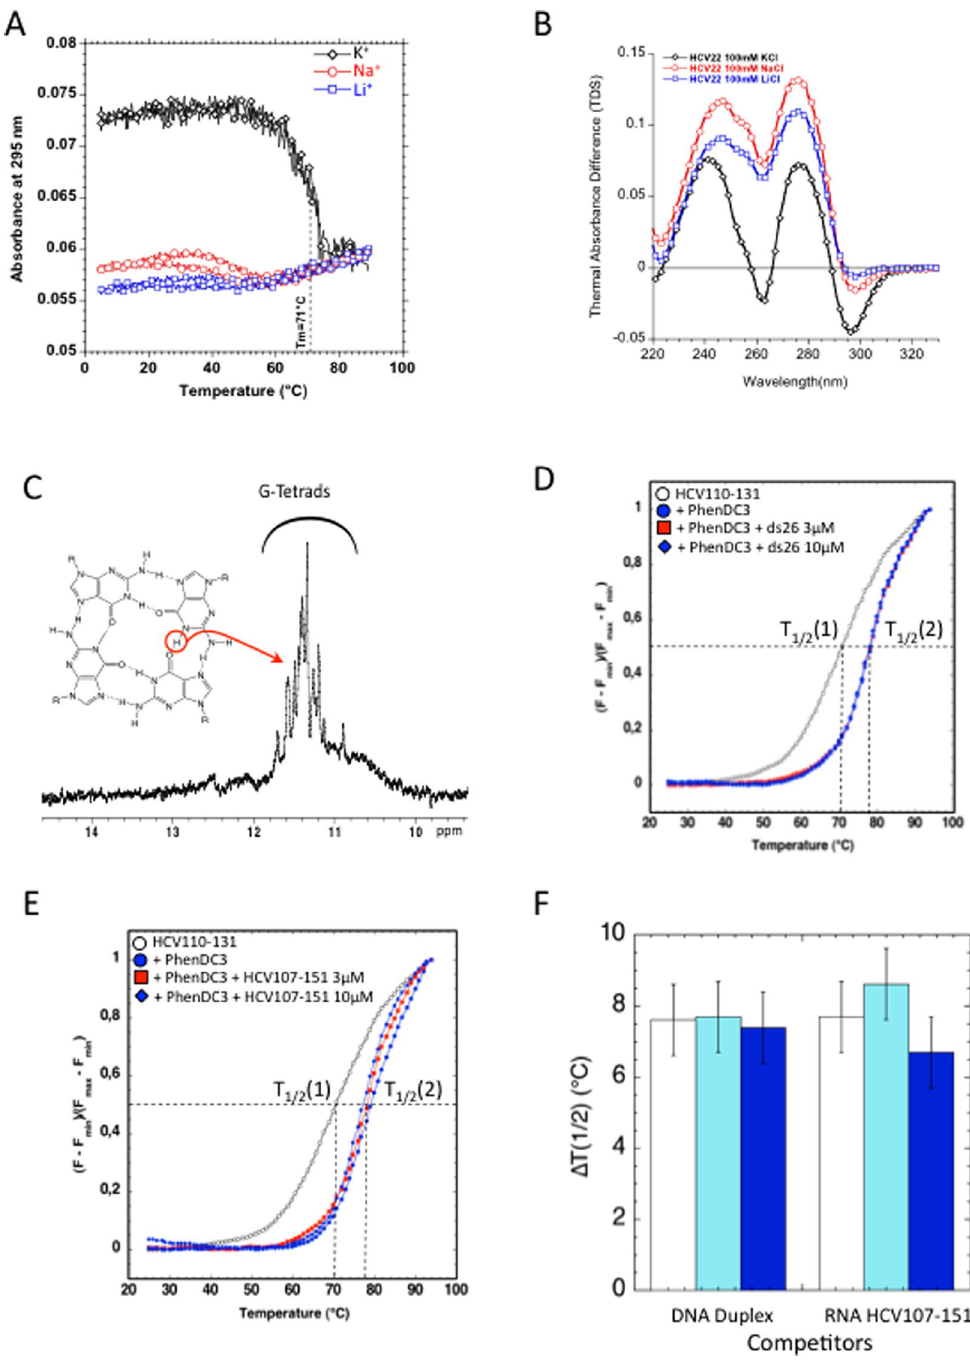
Figure 2. Biophysical evidence of RNA G4 formation at the 3 ′ end of HCV negative strand. ( A ) Melting profiles from HCV110-131 5 ′ CGGGAGGGGGGGUCCUGGAGGC3 ′ recorded at 295 nm in the presence of 10 mM lithium cacodylate buffer, pH 7.0 at 22 °C, containing either 100 mM of KCl, NaCl or LiCl. The HCV110- 131 oligonucleotide concentration was 2.5 µ M. ( B ) Thermal differential spectra recorded in the presence of 10 mM lithium cacodylate buffer, pH 7.0, containing either 100 mM of KCl, NaCl or LiCl. The HCV110-131 oligonucleotide concentration was 2.5 µ M. ( C ) 1 H, 1D NMR spectrum recorded in 20 mM potassium phosphate buffer, pH 7, containing 70 mM KCl. The oligonucleotide concentration was 100 µ M. D , E , F . FRET-melting assay recorded for f-HCV110-131-t RNA at 0.2 µ M in 10 mM lithium cacodylate pH 7.2 containing 10 mM KCl and 10 mM LiCl. ( D ) FRET-melting in absence of ligand (white circles) or in the presence of 0.4 µ M of ligand (blue circles, red square, blue square). For competition 3 µ M and 10 µ M of ds26 were added to the solution (red square and blue square). ( E ) FRET-melting in the absence of ligand (white circles) or in the presence of 0.4 µ M of ligand (blue circles, red and blue squares). For competition 3 µ M and 10 µ M of HCV107-151 were added to the solution (red square and blue square). ( F ) Histogram representation of the stabilisation induced by PhenDC3 in absence of competitor (white) or in the presence of 3 µ M (Cyan) or 10 µ M (Blue) of competitor ds26 or